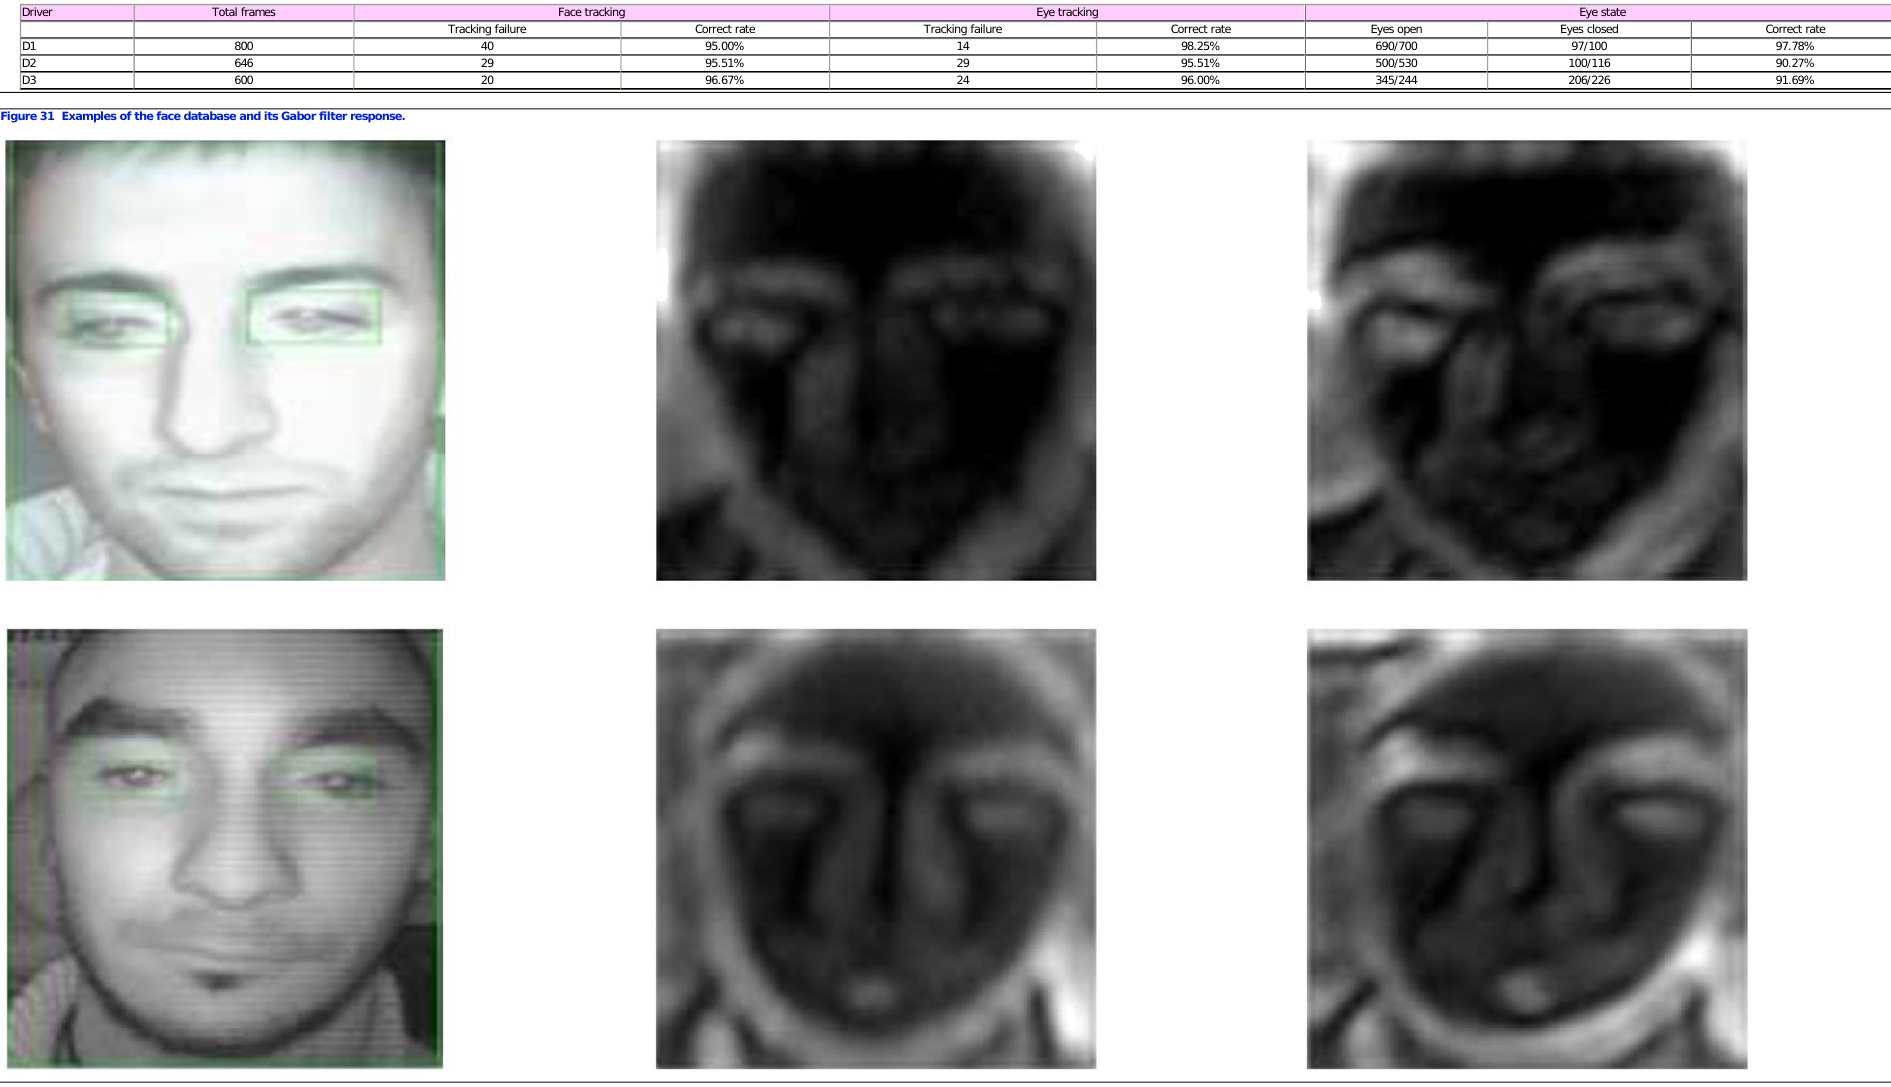
Figure 31 Examples of the face database and its Gabor filter